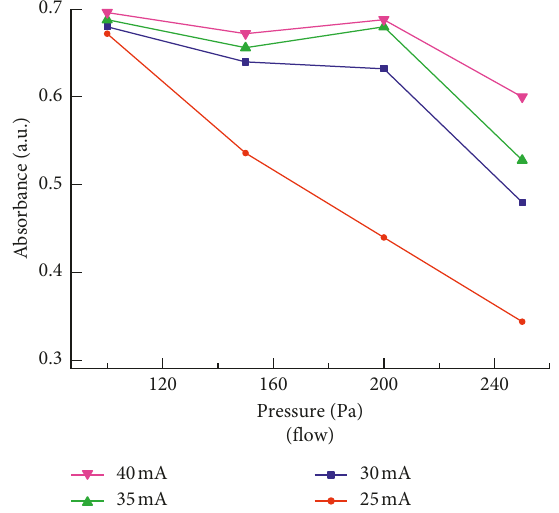
Figure 8: Change of absorbance of Ar under various pressures and currents in flow